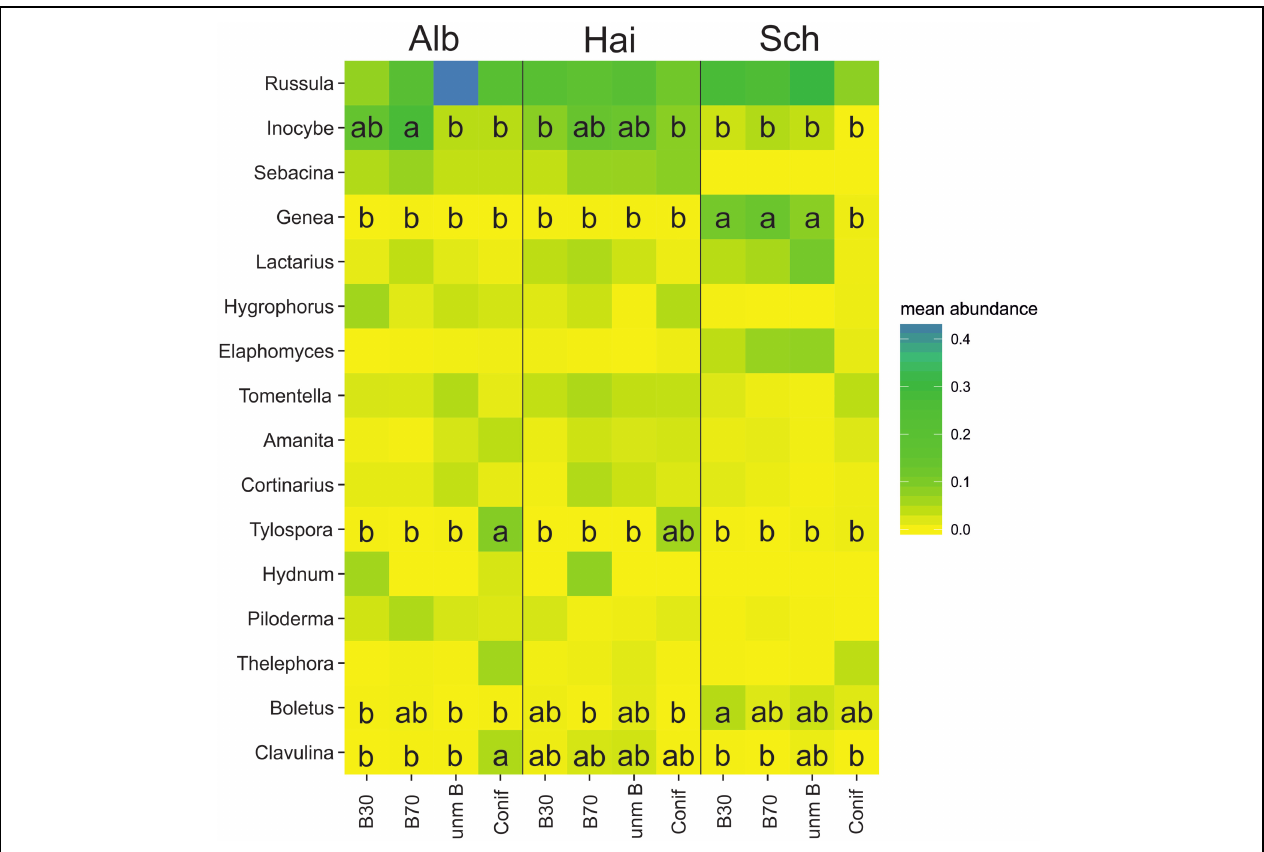
FIGURE 2 | Distribution of mean abundance of the most important ectomycorrhizal genera across the forest management types (young beech forest–B30, old beech forest–B70, coniferous forest–Conif, and unmanaged beech forest–unm B) at the study sites Alb - Swabian Alb, Hai - Hainich-Dün and Sch- Schorfheide-Chorin visualized on a heatmap. Mean abundances based on SIMPER using Bray–Curtis distance, plotting ectomycorrhizal genera contributing to a cumulative percentage of 90%. Different letters within squares indicate significant differences ( p < 0.05) based on Tukey post hoc pairwise